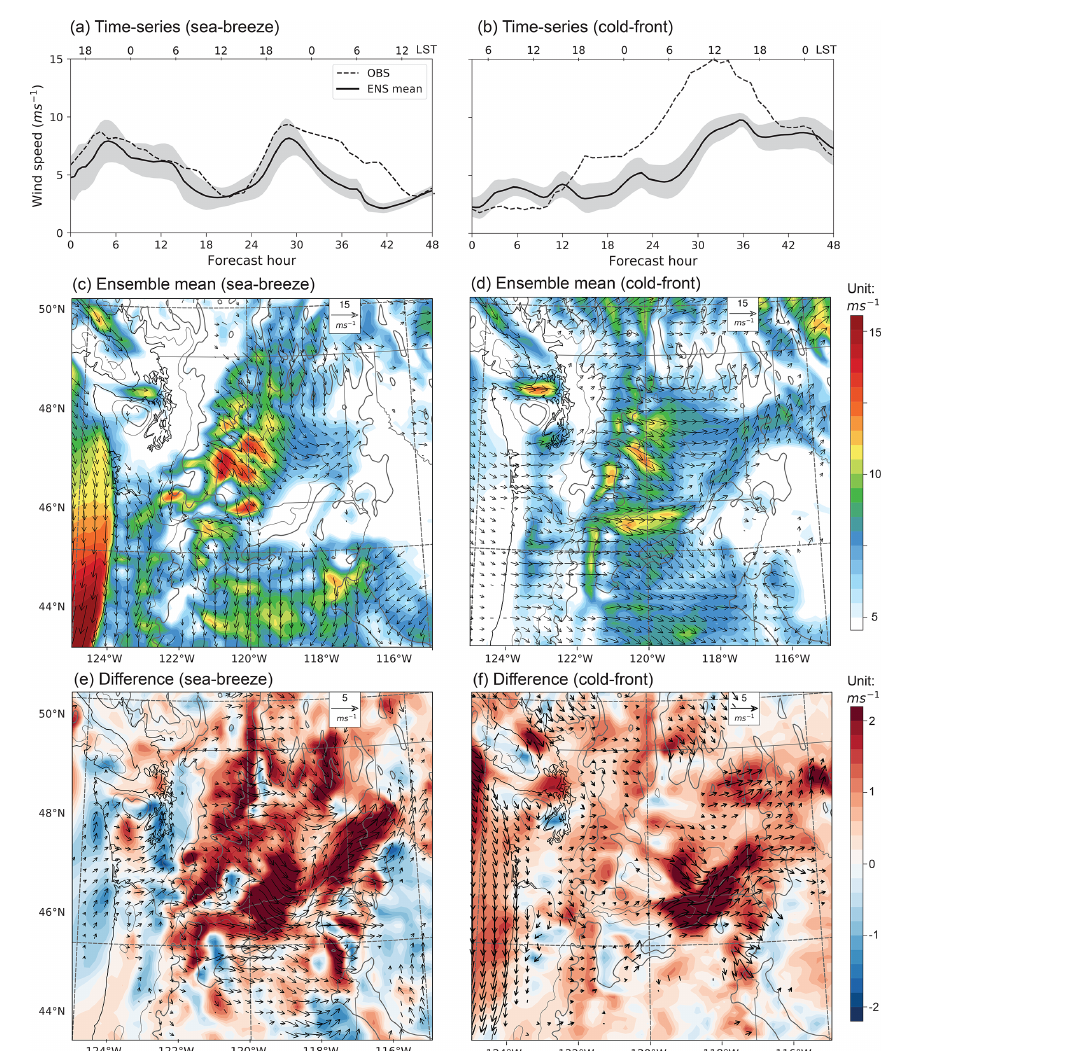
Figure 2. (a) Time series of observed and simulated turbine-height wind speed computed across 13 observation sites, as well as time series of the simulated range between the 2.5th and 97.5th percentiles of ensemble members, (c) ensemble mean wind speed at 29h, and (e) composite differences between two sets with wind speed greater or less than the ensemble mean at 29h for the sea-breeze case. Panels (b) , (d) , and (f) are the same as panels (a) , (c) , and (e) , respectively, but for the cold-front case and (d, f) at forecast hour 35. LST in panels (a) and (b) stands for local solar time. Gray lines in panels (c) – (f) indicate terrain elevation of 500 (thin) and 1000m (thick). Wind vectors are shown when either the zonal or meridional wind anomalies are greater than 5ms − 1 (c, d) and significant at the 0.05 level (e, f) ,